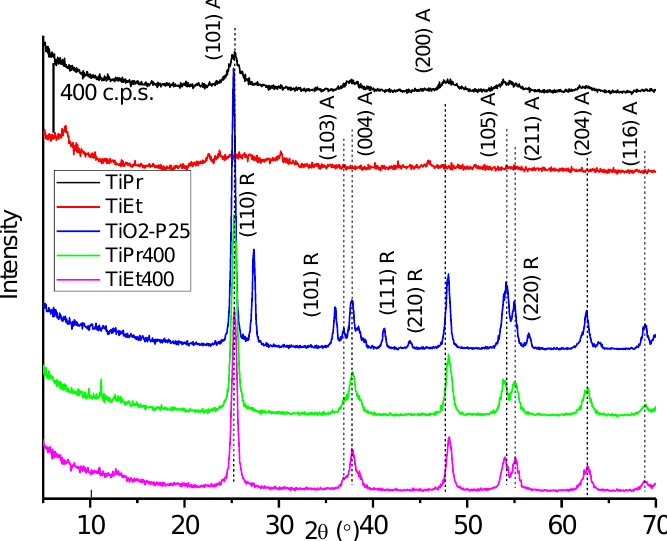
Figure 1. Powder X-ray diffractograms of samples TiPr, TiEt, TiPr400, TiEt400 and of TiO 2 -P25. For the calcined samples, TiEt400 and TiPr400, the diffraction peaks (Figure 1) were recorded at 25.3, 37.9, 48.1, 54.0, 62.8 and 69.0 ◦ (2 θ ) (3.51, 2.37, 1.89, 1.69, 1.48 and 1.36 Å, respectively). The diagrams are almost identical to each other, concerning the positions and relative intensities of the diffraction peaks. In both cases the only crystalline phase identified was anatase. On the other hand, commercial titanium oxide TiO 2 −P2 5 is known to be composed of approximately 80% anatase 20% rutile (JCPDS 21 − 1276) [34,35], alt- hough these value can change from one batch to another. The diffraction peaks of